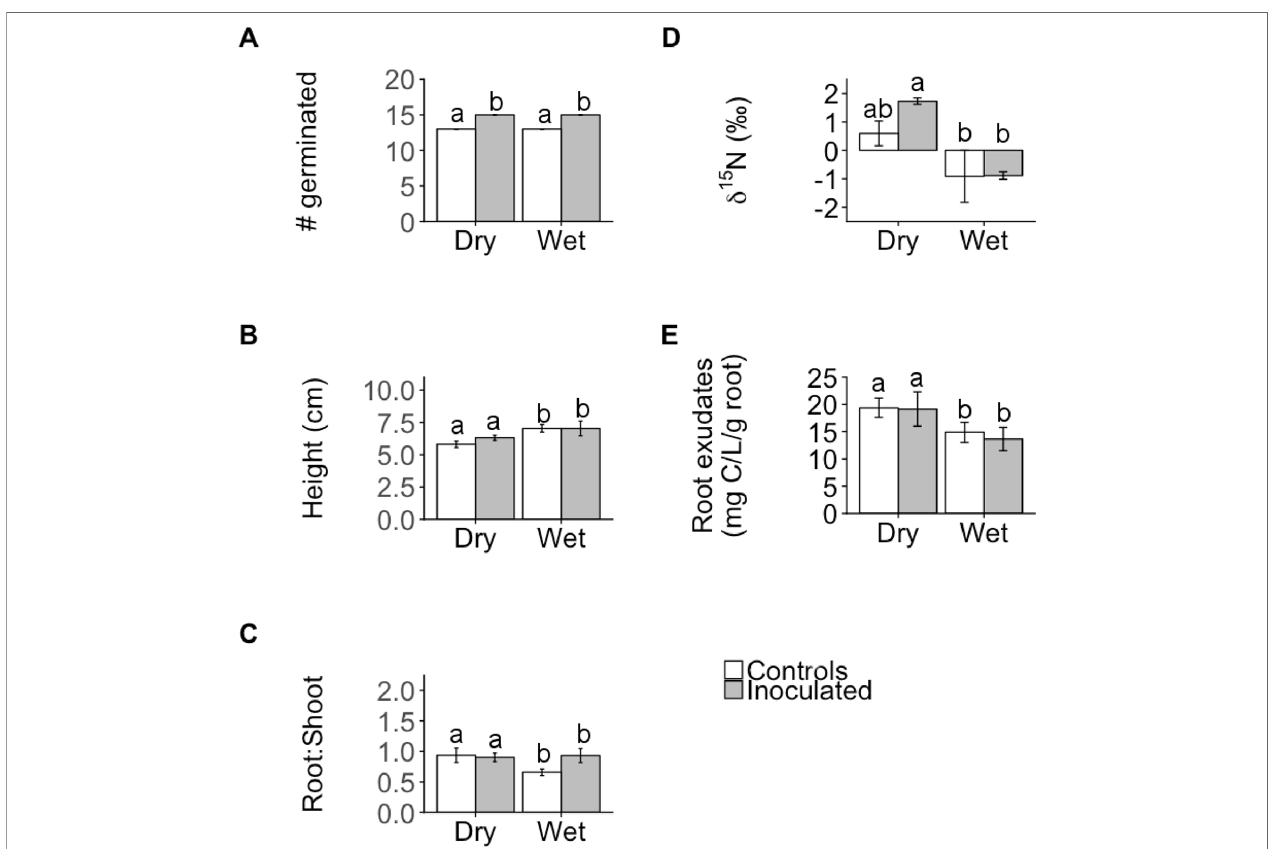
FIGURE 2 | Mean number of individuals germinated (A) , shoot height (B) , root:shoot biomass ratio (root:shoot; C ), leaf N isotope ratios ( d 15 N; D ), and root exudate concentration (E) of control and inoculated groups in dry and wet families. Letters indicate statistically signi fi cant differences among the four groups at P ≤ 0.05. Error bars represent ± SE. N = 4. Seedlings were ~11 months old for all measurements except germination (14 days old) and height (~9 months